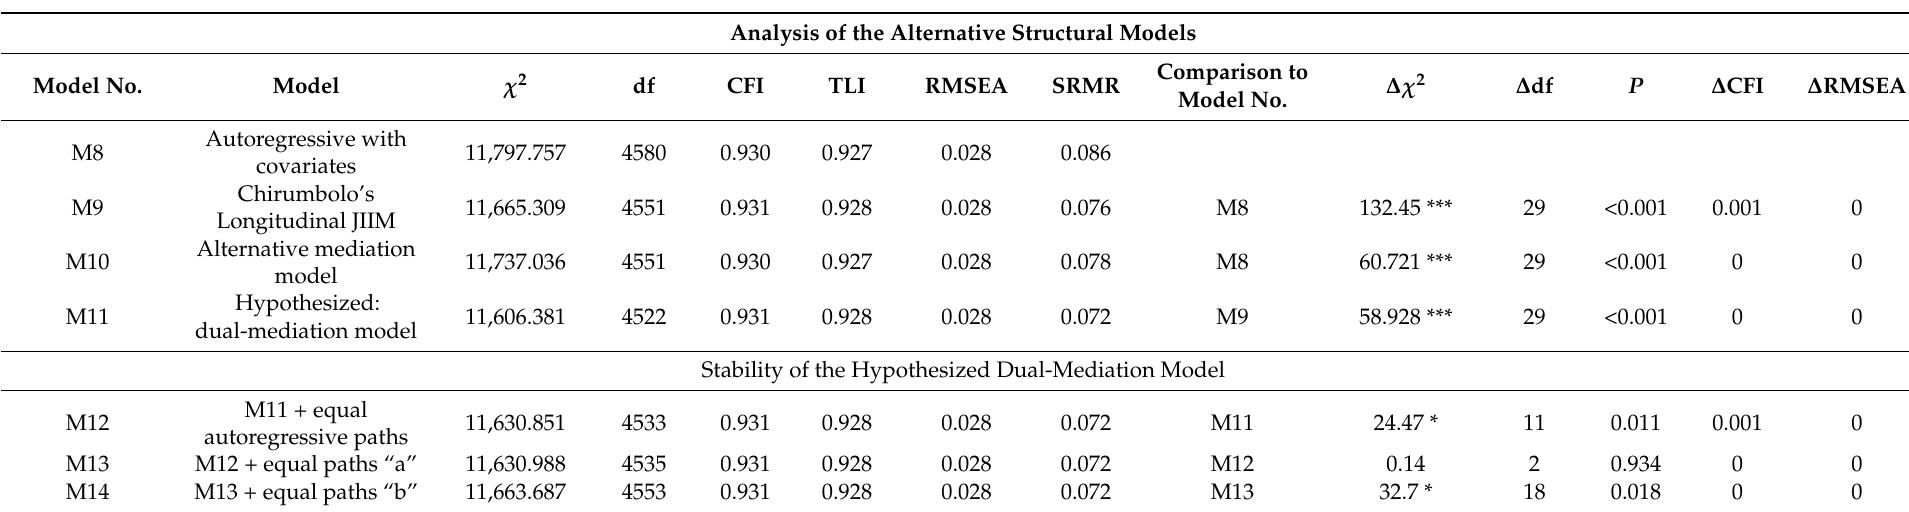
Table 3. Test of alternative structural and time